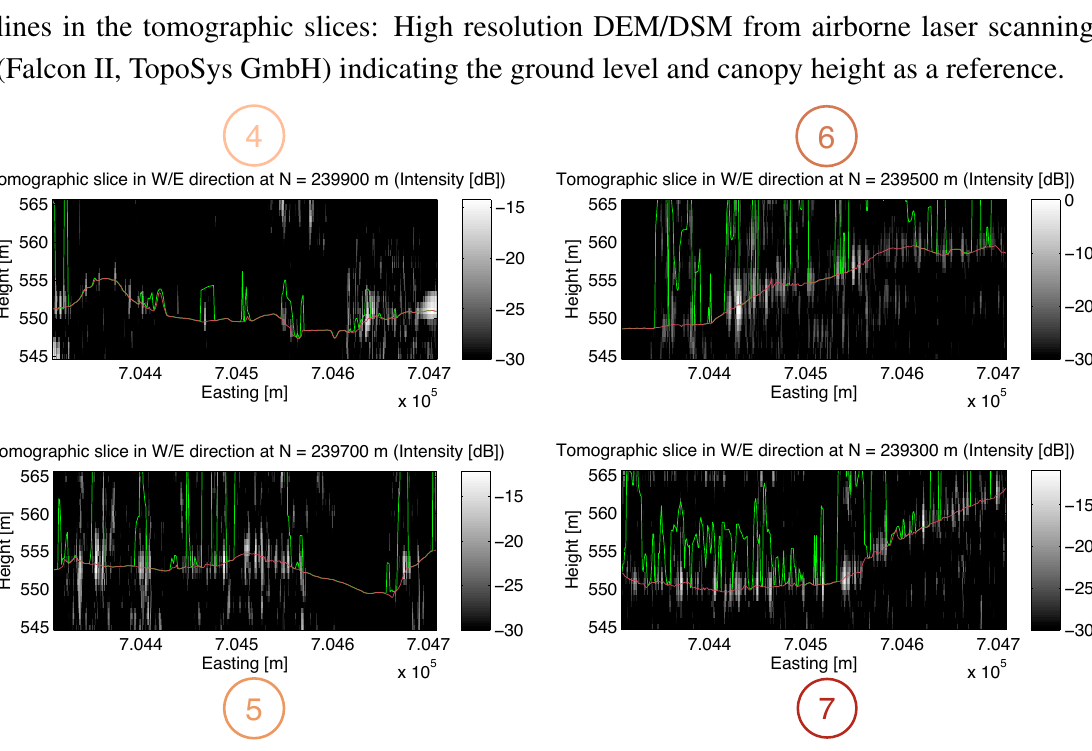
Figure 6. Vertical slices of the SAR tomographic image in west-eastern direction. Red/green